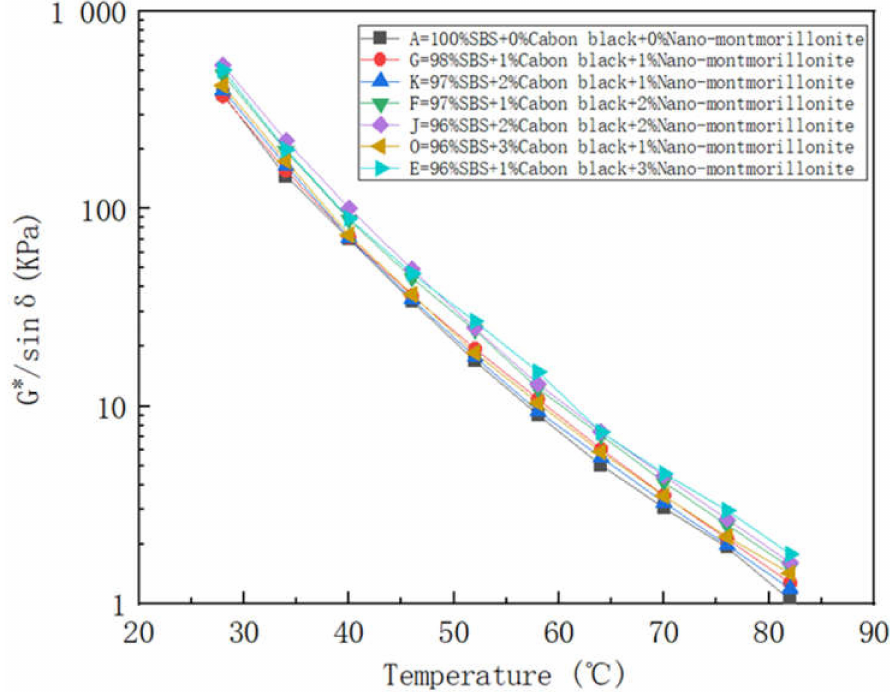
Figure 4. Relationships between complex modulus and temperature in DSR temperature scanning tests of various